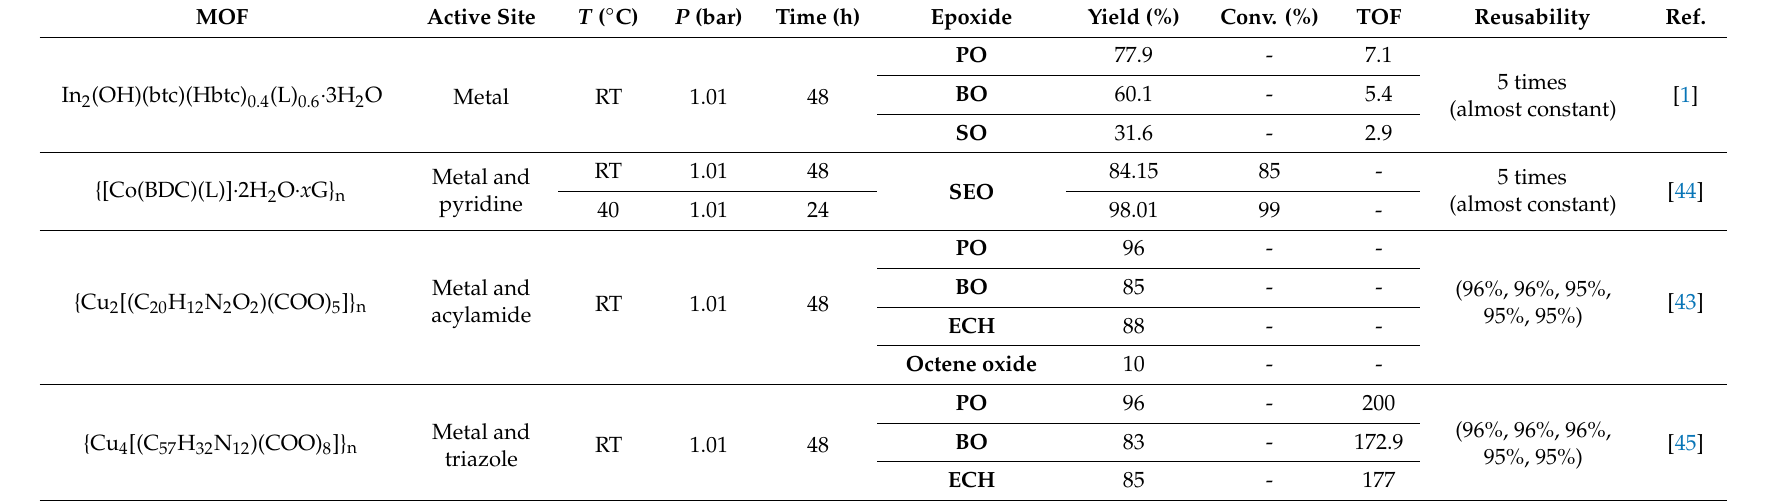
Table 3. Metal organic framework (MOF) catalysts for cycloaddition of CO 2 to